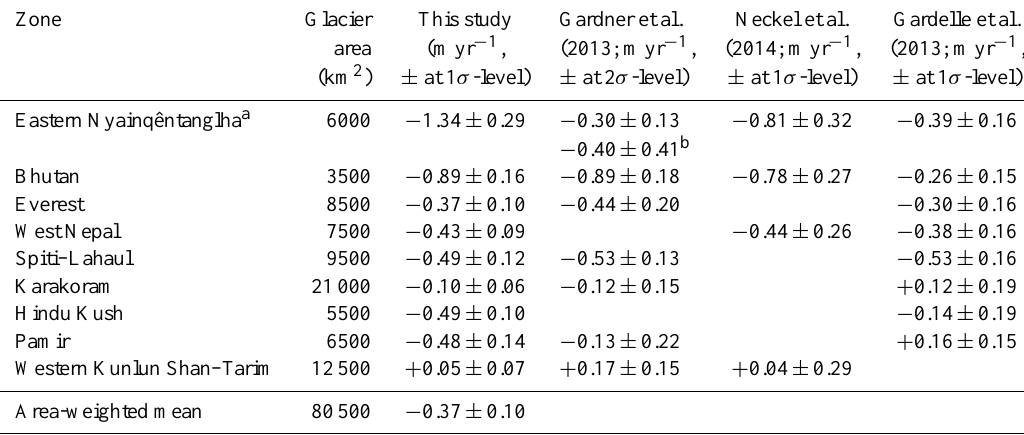
Table 1. Glacier elevation difference trends over the Pamir–Karakoram–Himalaya from this and other studies. Note that Gardelle et al. (2013) cover the period 2000 to ∼ 2010, while the other studies cover 2003 to 2008/2009. Note also that the zones of this study and Gardelle et al. (2013) coincide whereas the zones of the other do so only roughly, which can potentially explain parts of the disagreements. See text in Sects. 3 and 4 for an explanation of how the glacier areas were estimated.